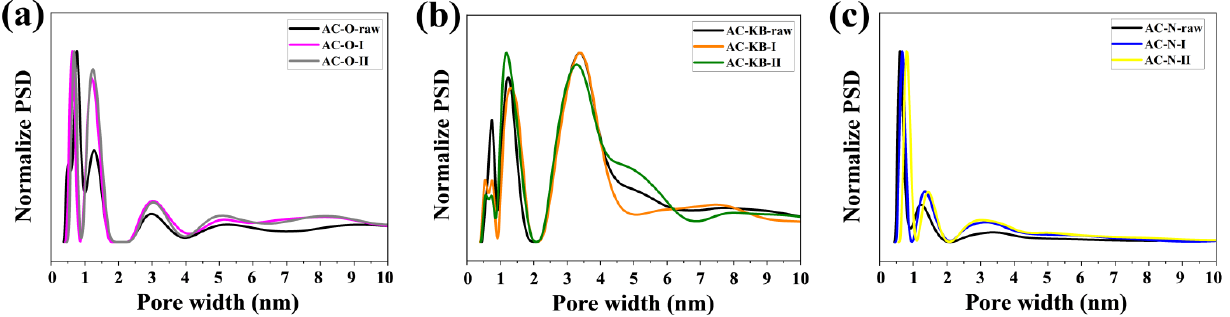
Figure 3. Nitrogen adsorption–desorption isotherms of all investigated series of the obtained samples: ( a ) AC–O; ( b ) AC–KB; and ( c ) AC–N.